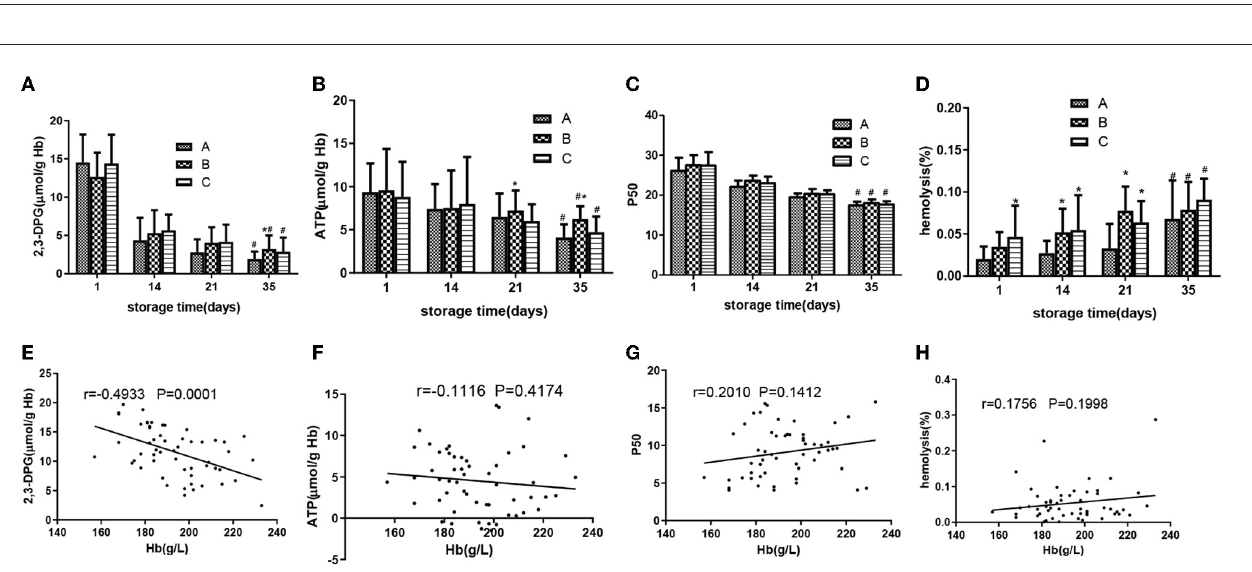
FIGURE5 SRBCs in different groups were measured during a 35-day storage period. 2,3-DPG (A) , adenosine triphosphate (ATP) (B) , P50 (C) , and hemolysis (D) . Associations of change amount during the storage of 2,3-DPG (E) and Hb, ATP (F) and Hb, P50 (G) , hemolysis (H) , and Hb. Pearson’s partial correlation analysis was used. *ANOVA p < 0.05 [ (A) p = 0.030, (B) p = 0.013, 0.041, 0.019, 8.84E-10, (D) p = 0.004, 0.034, 0.011, 9.76E-5, 0.009] in comparison to group A on days 1, 14, 21, and 35. # ANOVA p < 0.05 [ (A) p = 5.45E-6, 0.010, 4.78E-6, (B) p = 0.020, 0.046, 0.035, (C) p = 0.037, 0.032, 0.035, (D) p = 0.26, 0.031, 0.028] for all parameters on day 1 vs. day